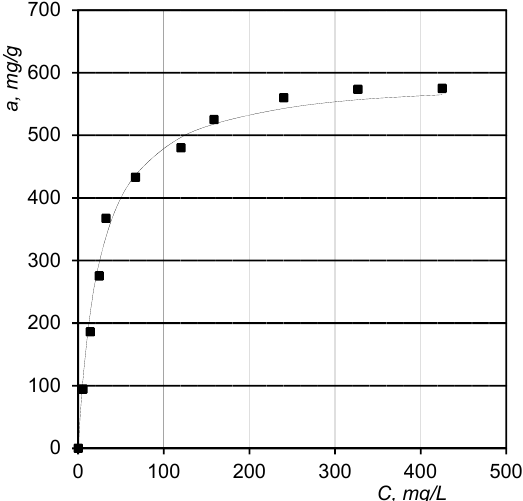
± 0.1 °C; Ph = 6.80 ± 0.05;